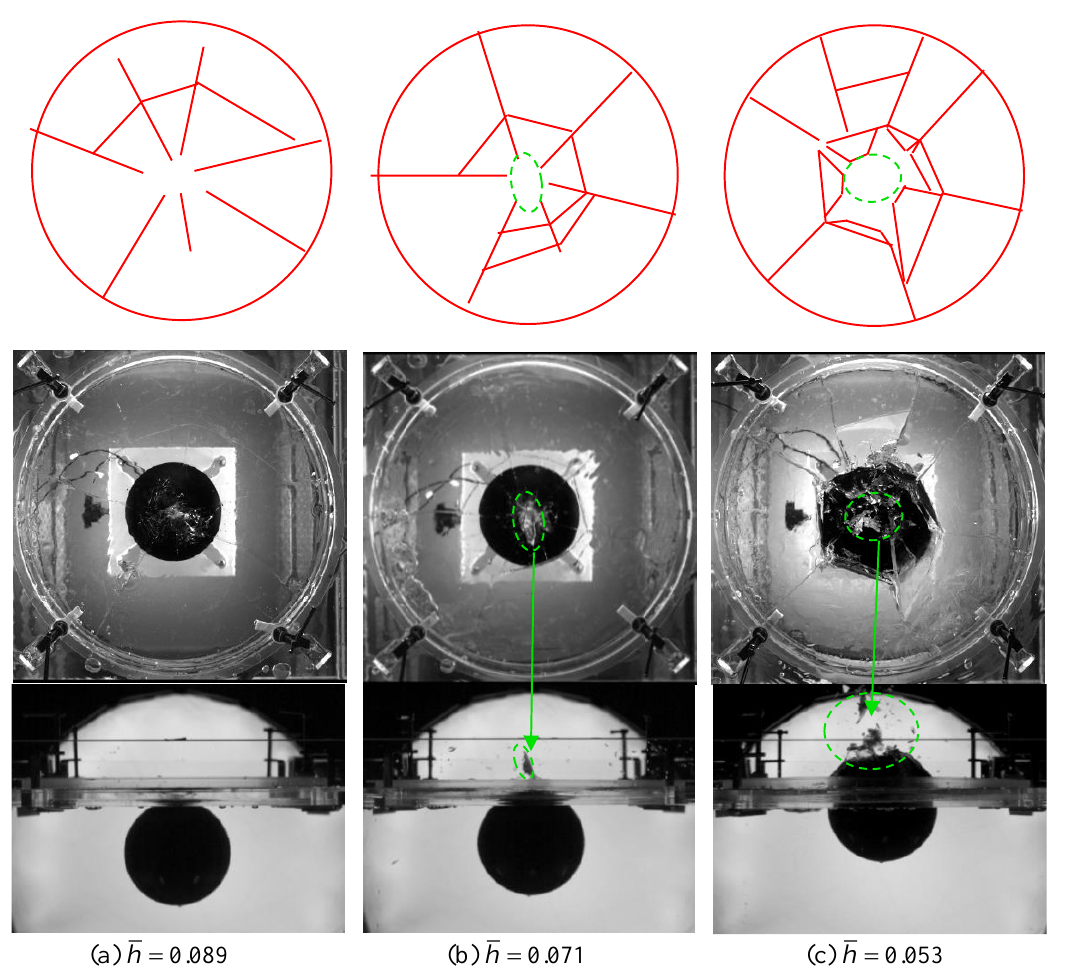
Figure 11. Typical damage patterns of ice plates with different dimensionless thickness h with the initial condition of ρ = 0.6 and L 0 = 2.31 when t (cid:48) = 0.1 s. (upper photos are captured a from bird’s eye view by Camera 2 and lower ones are captured from a horizontal perspective by Camera 1).